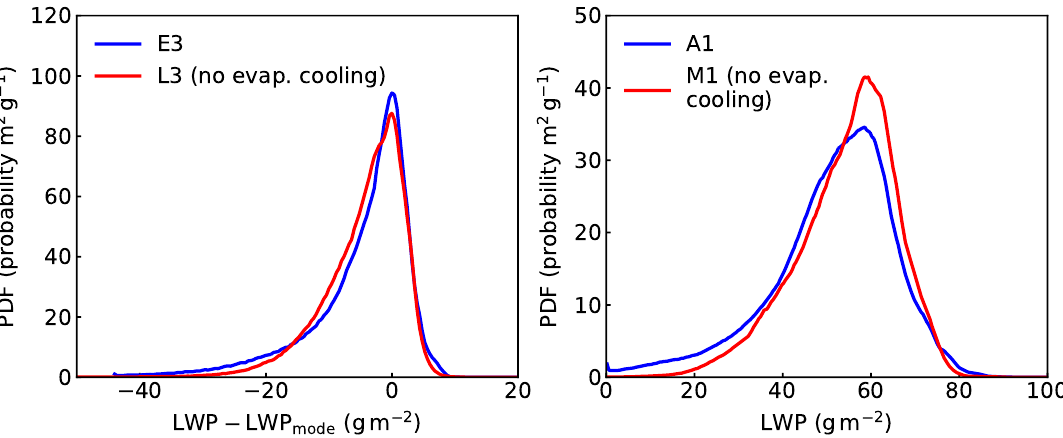
Figure 11. Probability Density Functions (PDF) of LWP for Cases E3 and L3 ( left ) and A1 and M1 ( right ). The LWP ( x -axis) in the left panel is shifted by the location of the mode of the PDF.